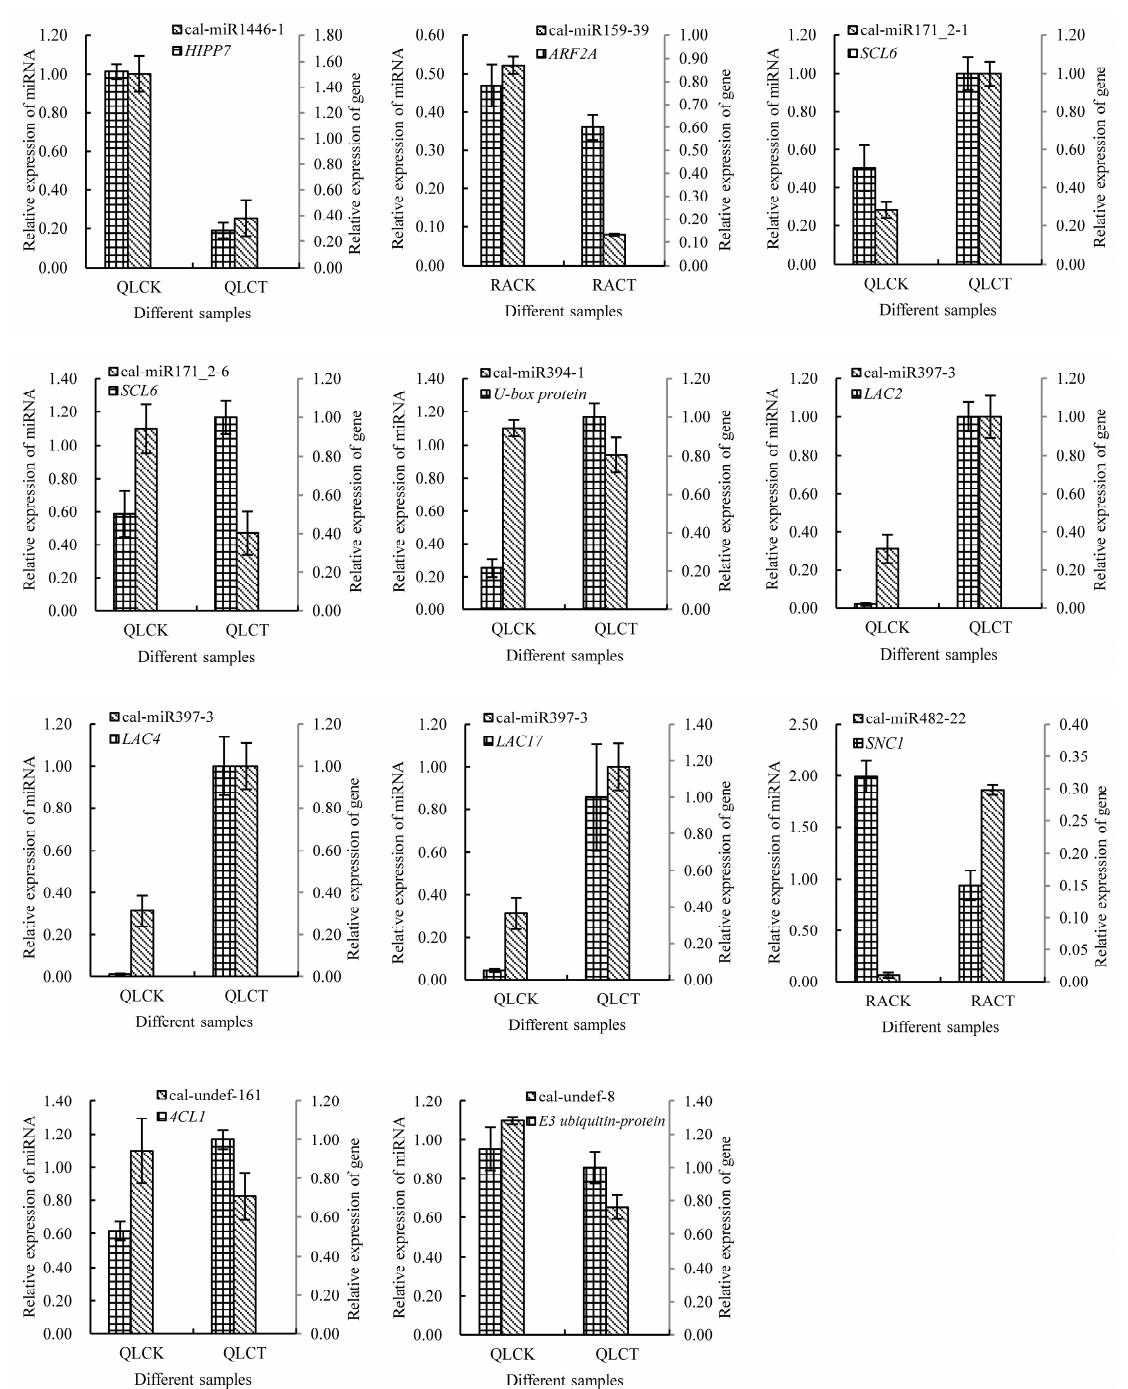
Figure 7. Quantitative real-time PCR results for DEMs and their corresponding target genes. By using PerfectStart ® Green qPCR SuperMix, qRT-PCR reactions were performed on a Roche LightCycler480 machine. The amplification procedure of qRT-PCR was shown as follows: pre-denaturation at 94 ◦ C for 30 s; denaturation at 94 ◦ C for 5 s, annealing and extension at 60 ◦ C for 30 s, 40 cycles. The sample was maintained at 94 ◦ C for 15 s, at 60 ◦ C for 15 s, and then raising the temperature to 94 ◦ C at the rate of 0.11 ◦ C · s − 1 and kept 15 s to draw the dissolution curve. The reaction system contained 10 µ L 2 × PerfectStart ® Green qPCR SuperMix, 0.2 µ M each upstream and downstream primer, 0.5 µ M cDNA template. Three biological replicates were made for each treatment and statistics analysis were performed using SPSS19.0 software (IBM, Armonk, NY,